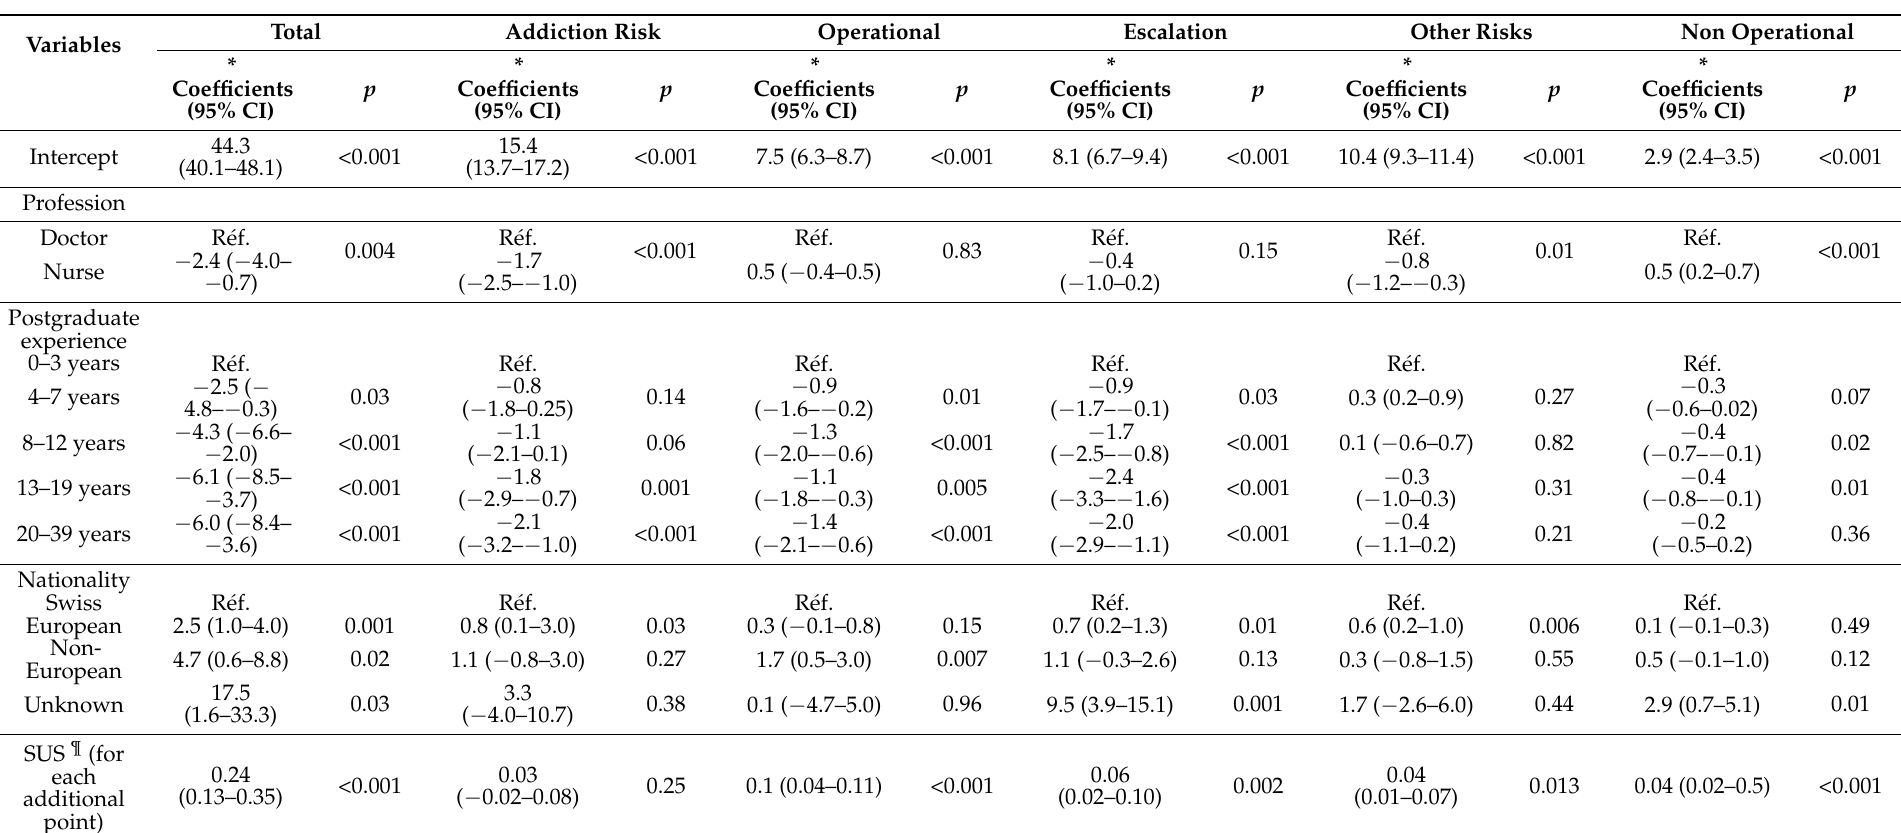
Table 3. Multivariate model predicting the “Attitude Towards Morphine Score (ATMS) and the scores of its 5